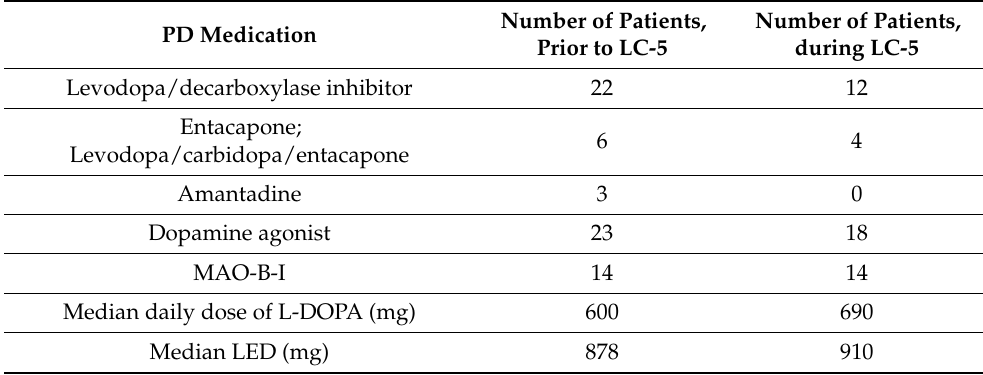
Table 2. Treatment with other dopaminergic Parkinson’s disease (PD) medication prior to LC-5 and concomitant PD treatment during LC-5 therapy ( n =